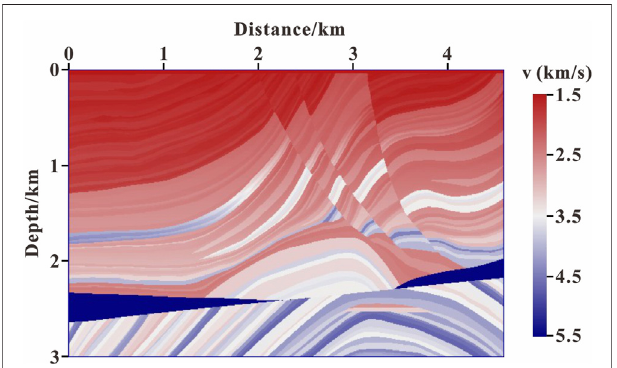
FIGURE 2 | Marmousi velocity model.